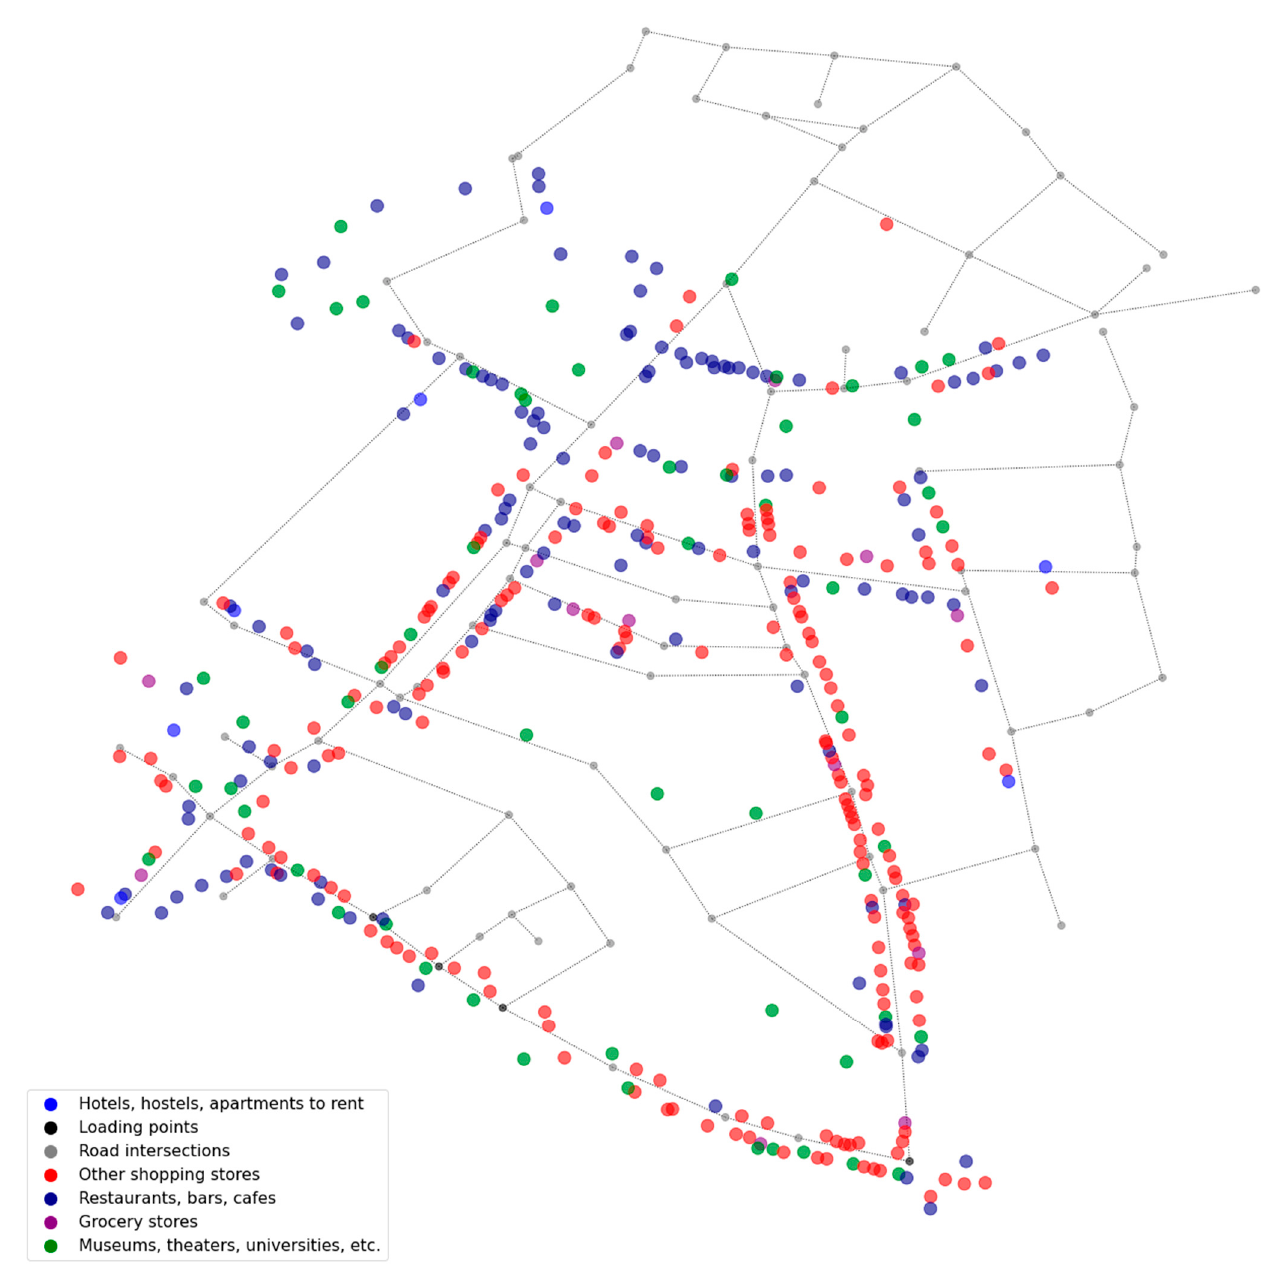
Figure 5. Location of the clients and the road network of the central district of